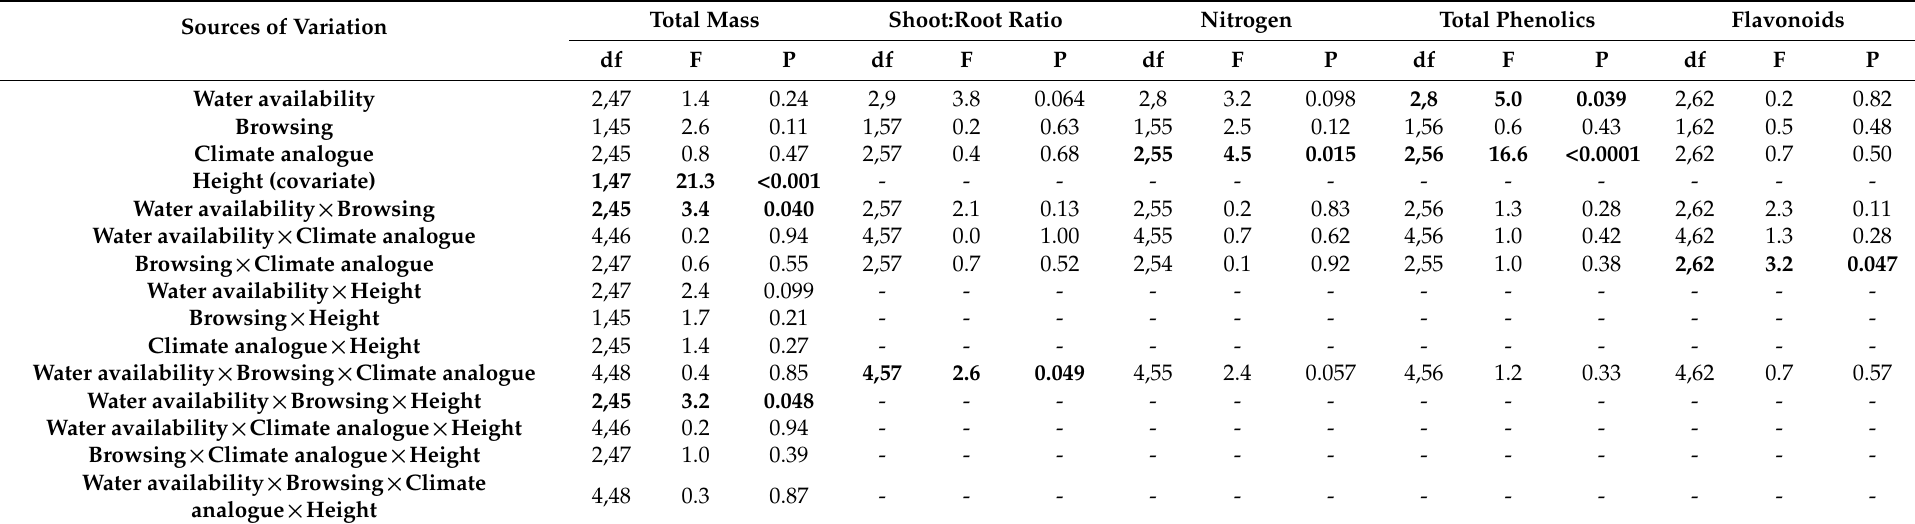
Table A6. ANOVA summary table for evaluating the effects of simulated winter browsing, water availability, seedling climate analogue (2018, 2050, 2080 analogues) and their interaction on northern white cedar ( Thuja occidentalis L.) total mass, shoot:root ratio and chemical composition (nitrogen, total phenolics and flavonoids concentration). Seedlings were grown under different levels of water availability during a ten week greenhouse